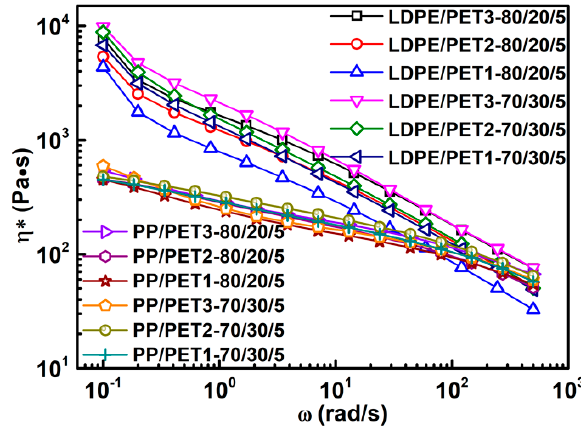
Figure 7. Complex viscosity for polymer blends with different IV of PET in the presence of compatibilizer.